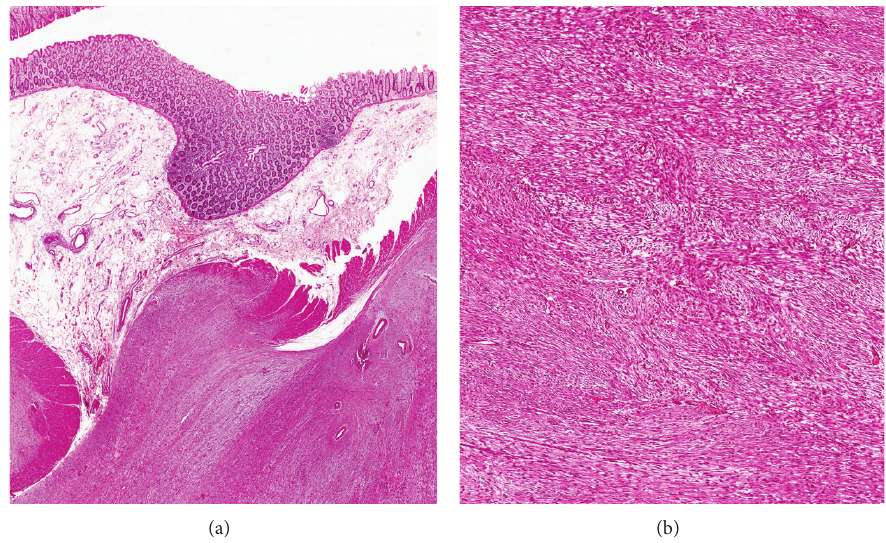
Figure 4: (a) Low magnification showing a fibrous proliferation involving smooth muscle layer of colonic bowel (hematoxylin and eosin; magnification × 60). (b) Higher magnification showing intersecting fascicles composed of bland-looking spindle-shaped cells (hematoxylin and eosin; magnification × 100). These morphological features are consistent with desmoid-type fibromatosis.